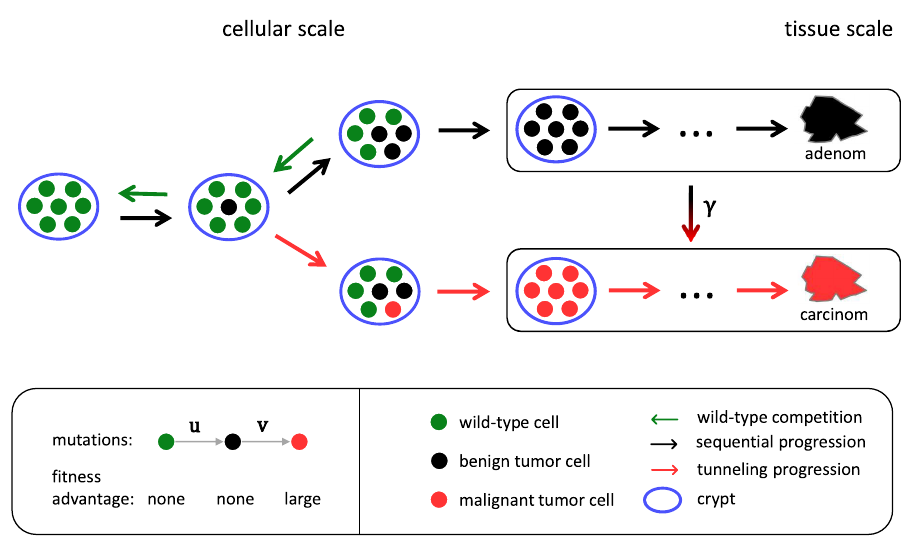
Fig 2. Illustration of the dynamics of the niche-competition-based pretumor progression model. Wild-type cells within the niche of a colonic crypt can progress to benign tumor cells, which can further progress to malignant tumor cells, during proliferation with mutation probabilities u , v . While wild-type and benign tumor cells neutrally compete by replacing each other in the niche with rate λ , malignant tumor cells rapidly dominate the niche. We assume that once no more wild-type cells are present in the niche (fixation or clonal inversion) tumor cells establish within the tissue via clonal expansion. Consequently, there are two possible progression pathways: (i) The niche consists of malignant tumor cells at fixation and an adenocarcinoma grows from the niche (tunneling progression). (ii) The niche consists of benign tumor cells at fixation and the resulting tumor progresses with probability γ at some point during growth to an adenocarcinoma (sequential progression, precancerous